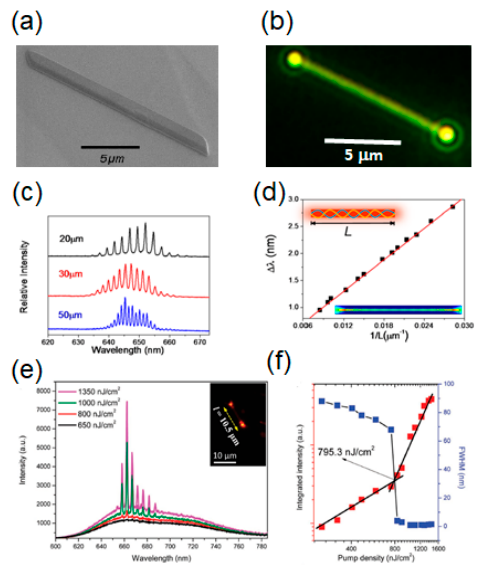
Figure 11. ( a ) Scanning electron microscope image of a BP2T-CN crystal wire. ( b )